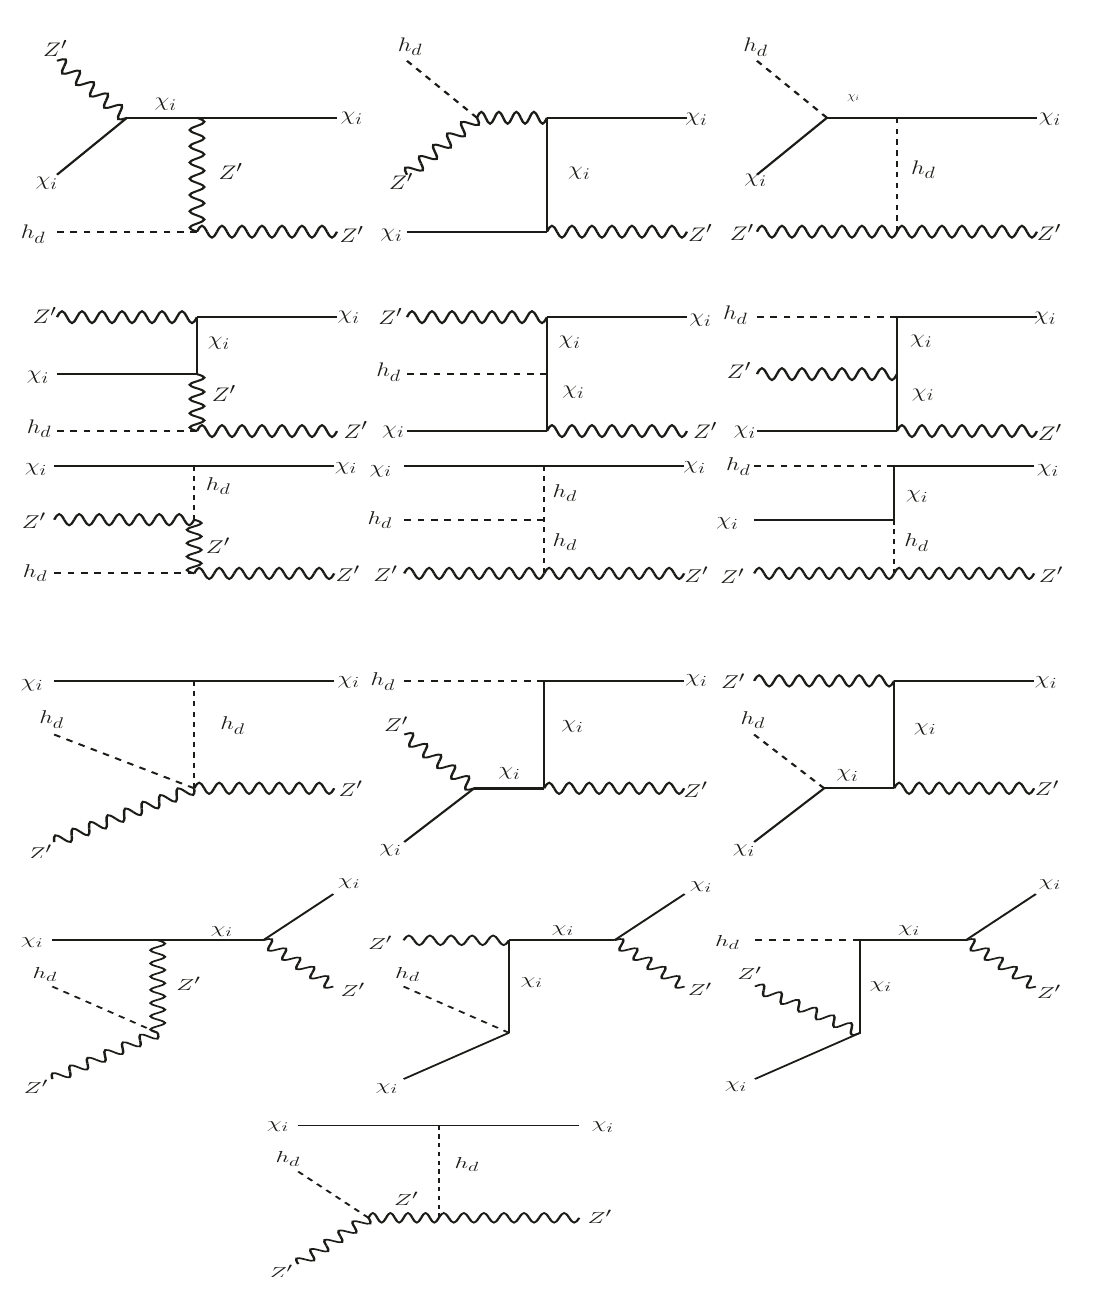
Z 0 h d → χ Z 0 i i